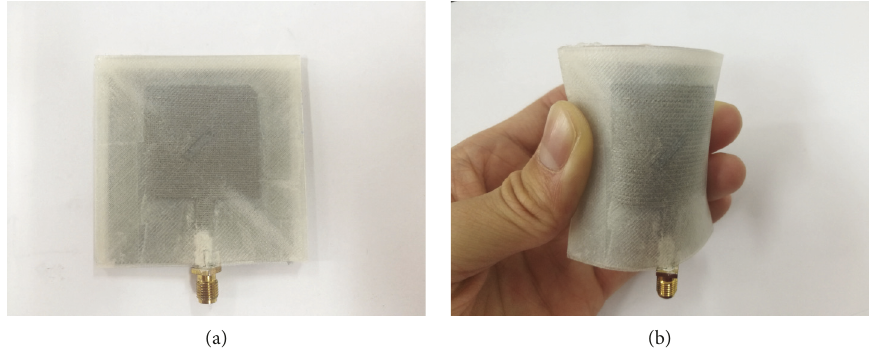
Figure 4: Photographs of the fabricated CP antenna. (a) Top view. (b) Bent view (bending along the y -axis).